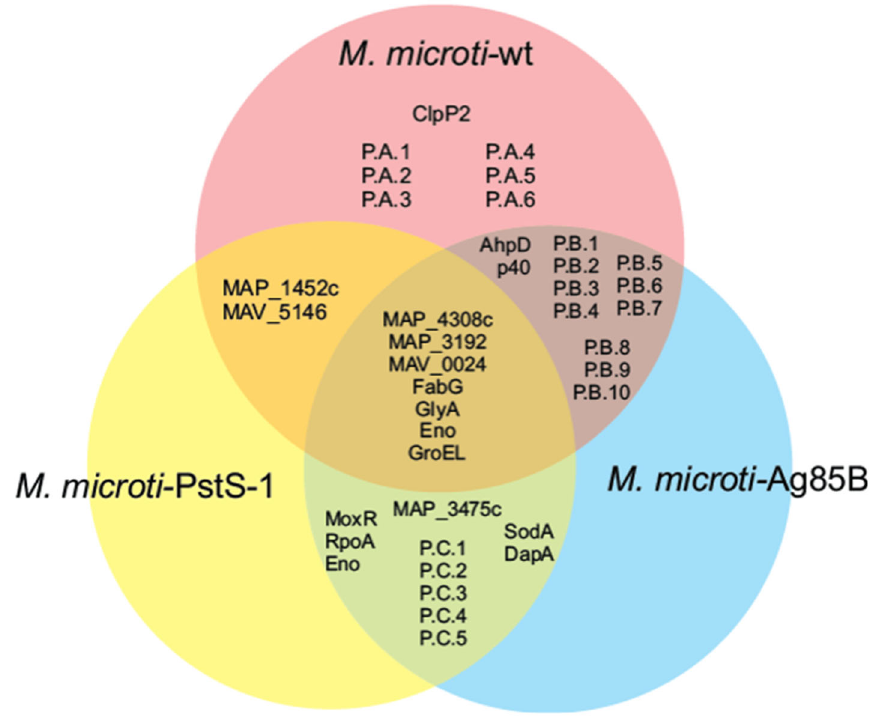
Figure 5. Venn diagram of the differential expression proteome of the cellular extract from M. microti strains. P.A, P.B and P.C: protein spots from Figure S3A–C, respectively.